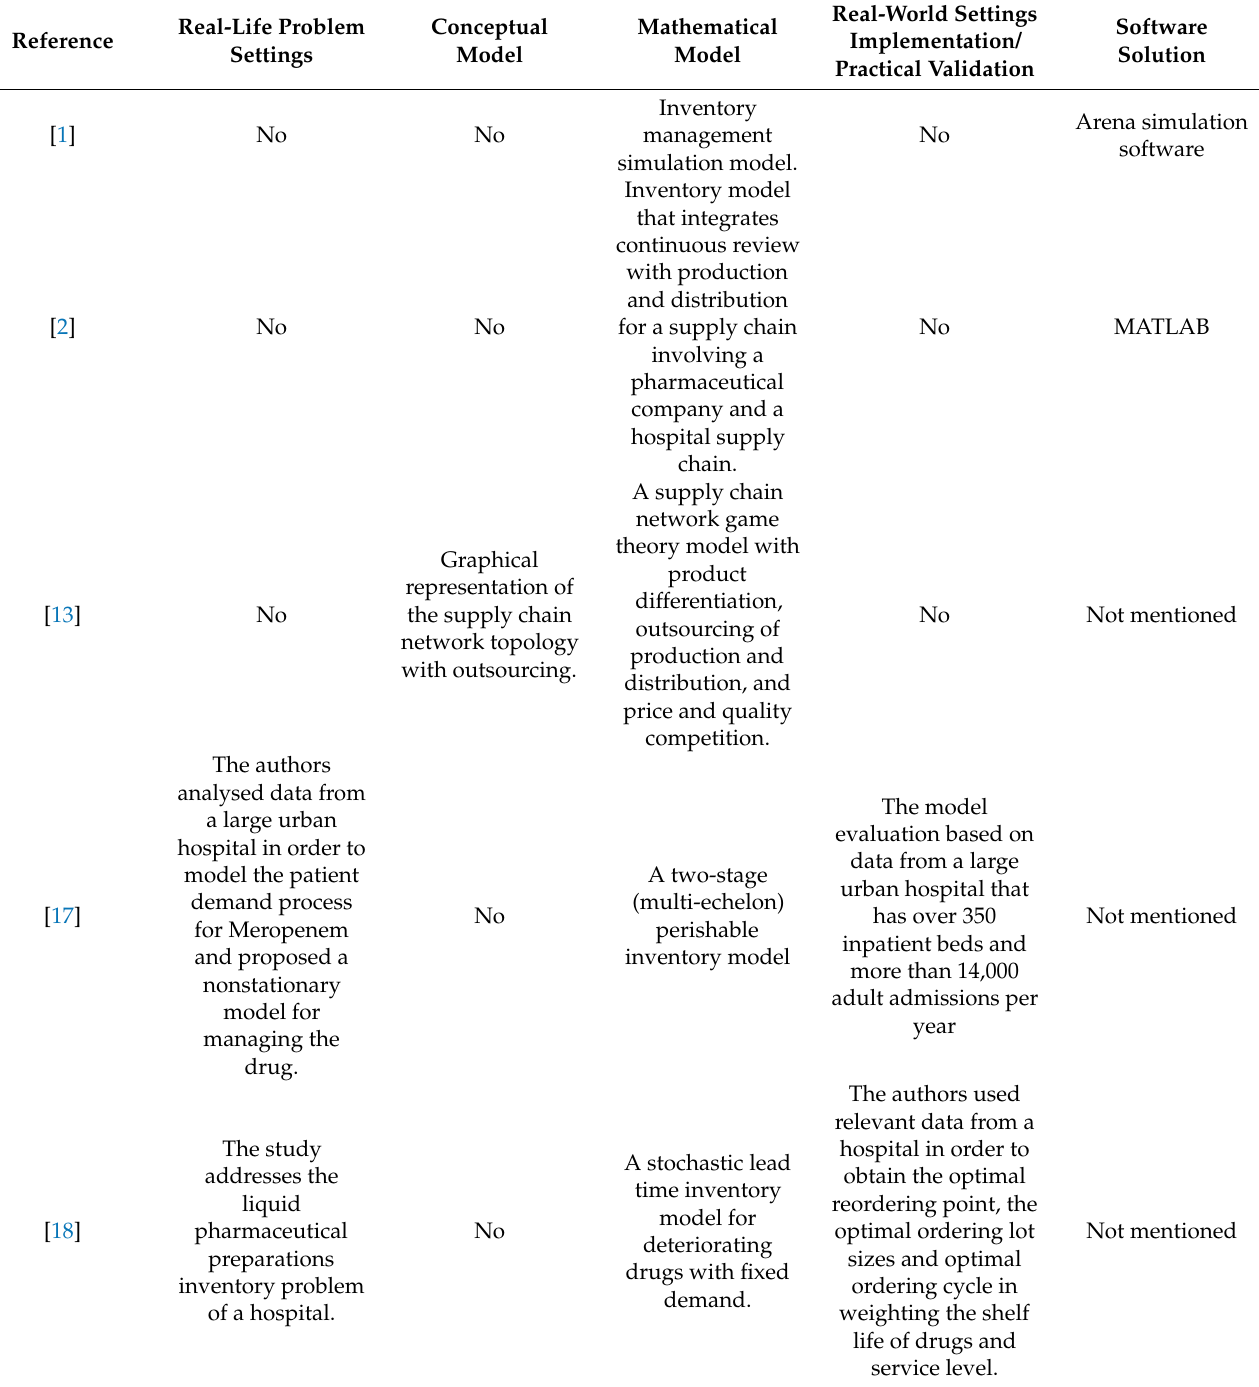
Table 1. Comparison of the proposed approach characteristics and related